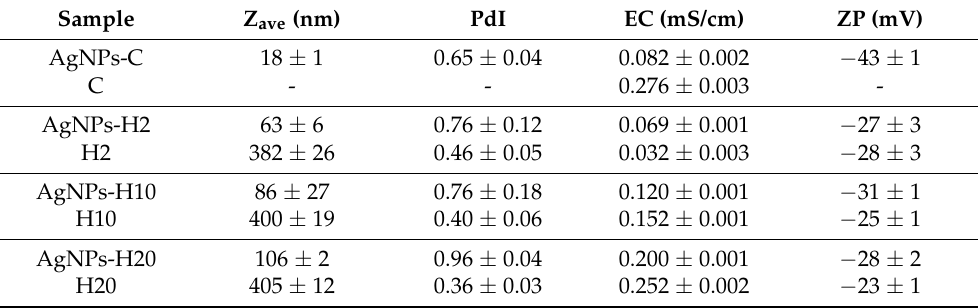
Table 1. The properties of both the samples after AgNPs synthesis and the initial solutions used. Sample Z ave (nm) PdI EC (mS/cm) ZP (mV)